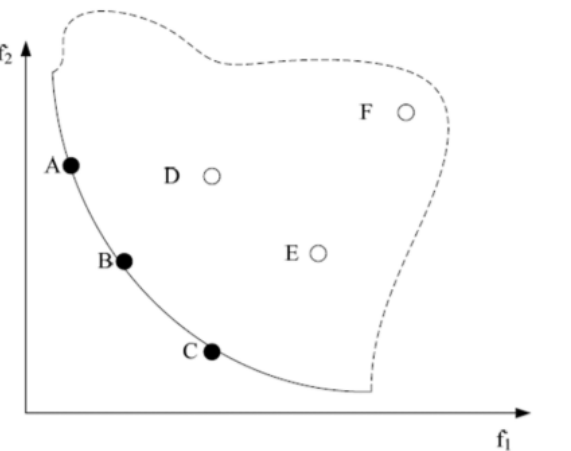
Figure 1. Schematic diagram of the pareto frontier distribution of two objective functions.